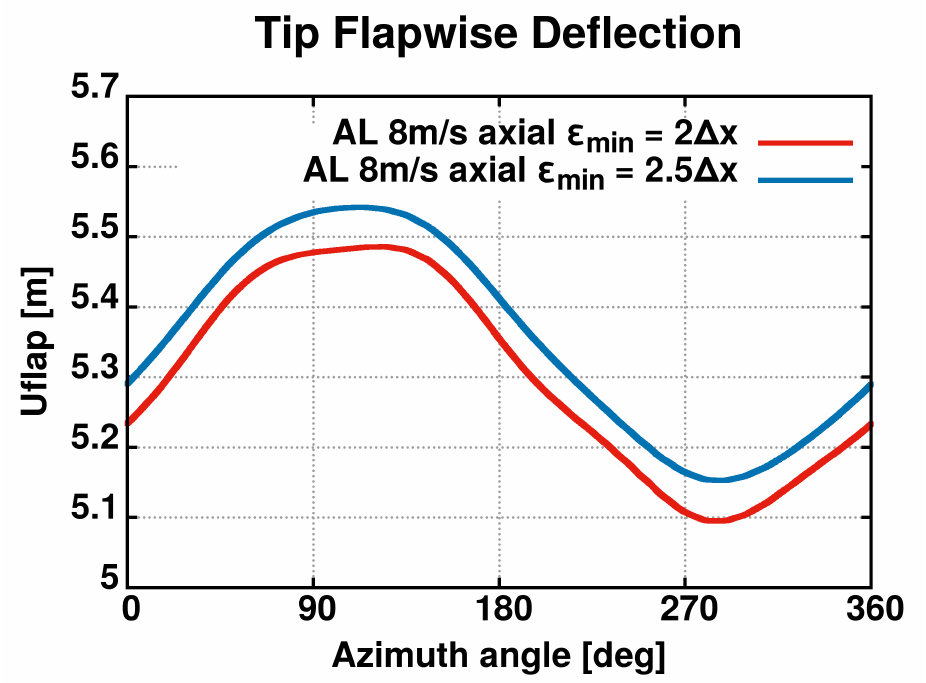
Figure 12. Minimum value of (cid:101) investigation. Flapwise deflection in axial uniform free-stream flow at 8 m/s.